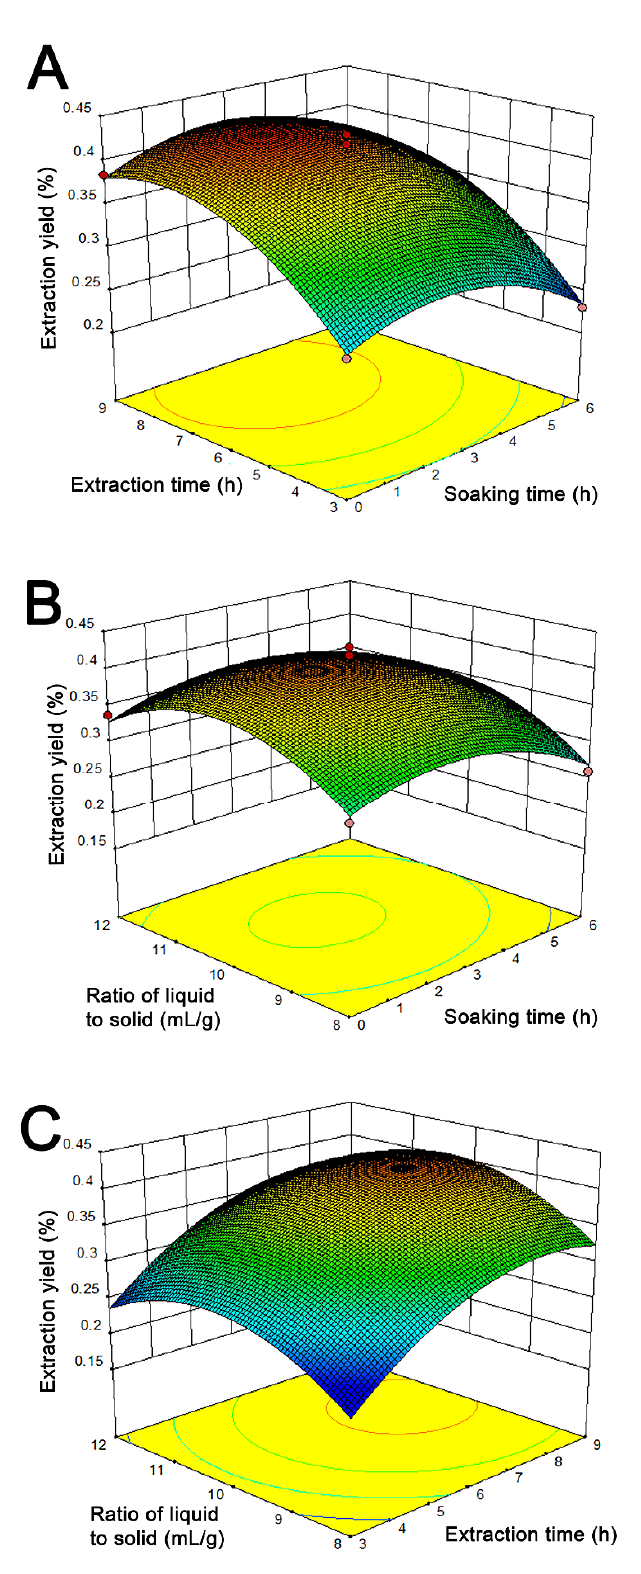
Figure 3. 3D response surface plots of the interaction effects between extraction time and soaking time ( A ), liquid to solid ratio and soaking time ( B ), liquid to solid ratio and extraction time ( C ) on the extraction yield of Polygonum orientale essential oil.